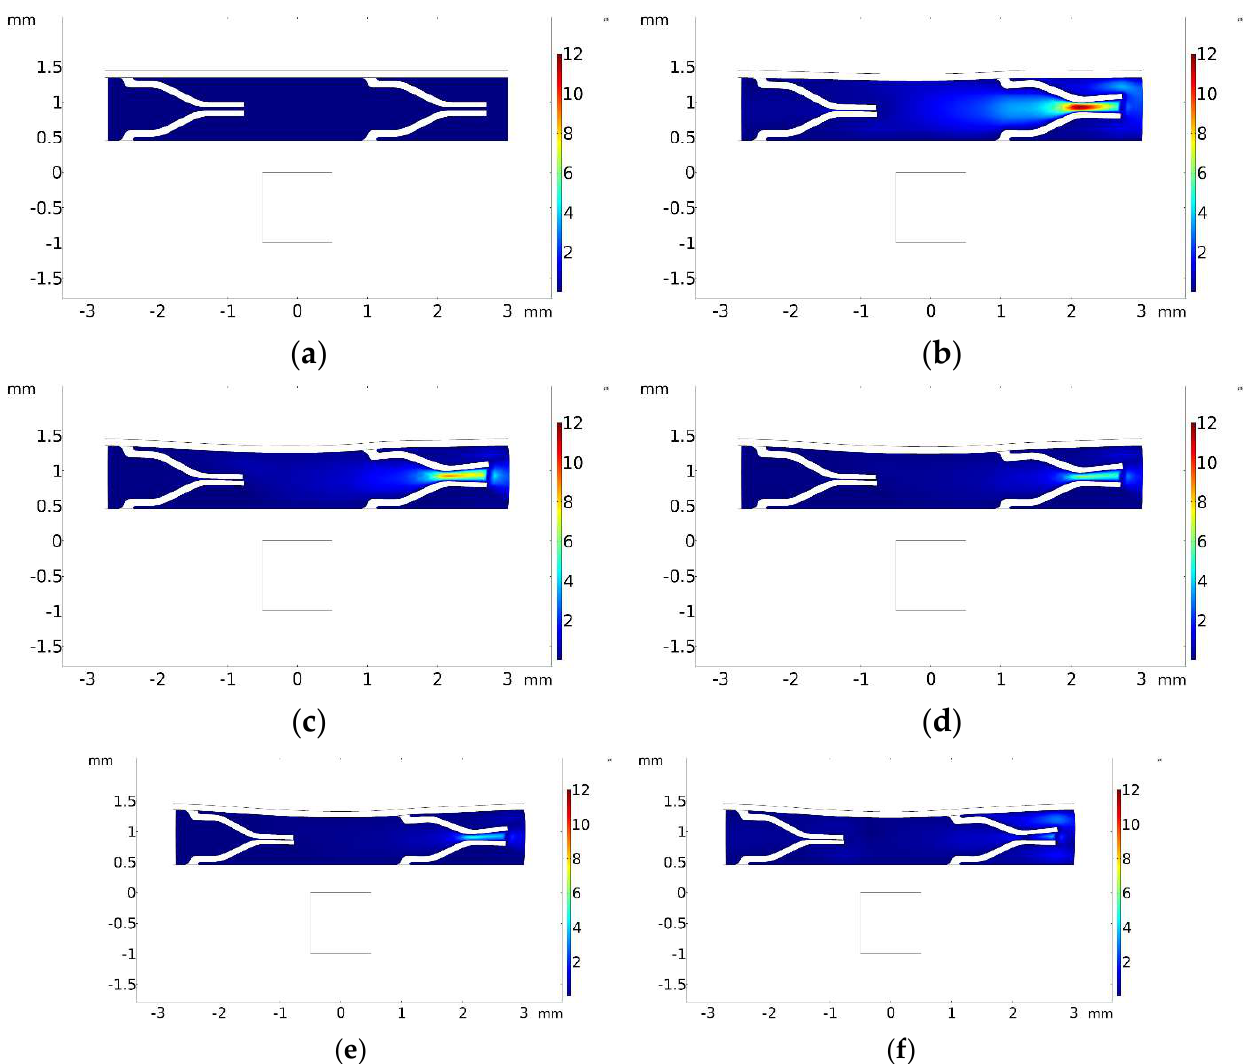
Figure 14. The deflection and velocity field history of the micropump during the contraction phase at t = 0–0.5 s. ( a ) The flow field at the beginning of the simulation at t = 0 s. ( b ) The MRE is started deforming downward, pushing the fluid toward the right terminal. The fluid shows maximum velocity at the right valve in this stage. ( c ) the upper wall deforms further, and thus, the right duckbill bends, but this time the tips of the right valve come closer to each other, thus decreasing fluid displacement ( t = 0.2 s). ( d ) The right duckbill valve deflects further and reduces the fluid flow, and the left valve closes completely to prevent the backward flow ( t = 0.3 s). ( e ) Deformation of the upper wall and duckbill valves continue ( t = 0.4 s). ( f ) the deflections on the upper wall ( t = 0.5 s). At this time, the micropump is about to start the expansion phase.